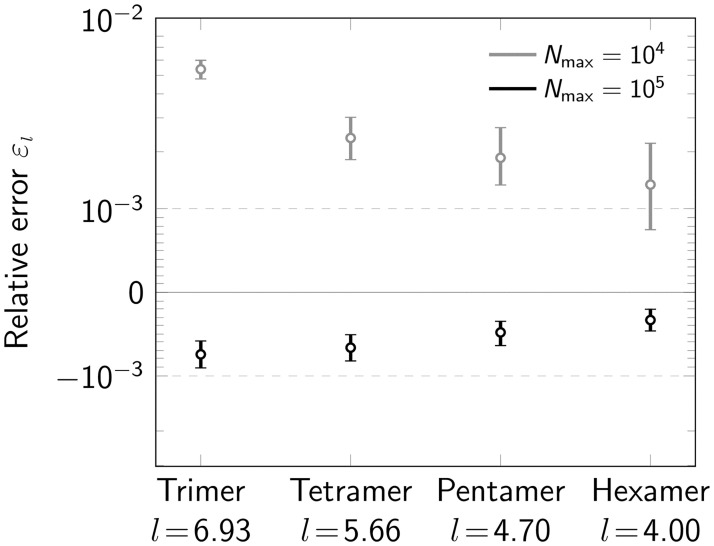
Influence of oligomerization degree.Relative error εl for varying degree of oligomerization (n = 3, 4, 5, 6) shown in a symmetric logarithmic plot. Data was simulated both for a maximum number of photons Nmax = 104 (gray) and Nmax = 105 (black). Positive and negative relative errors represent overestimation and underestimation, respectively. For each data point 500000 oligomers were simulated. The radius of the circumscribed circle of the oligomer was set to 4 nm. The resulting side length for each oligomer type is indicated on the x-axis. Error bars indicate the 95% confidence intervals.